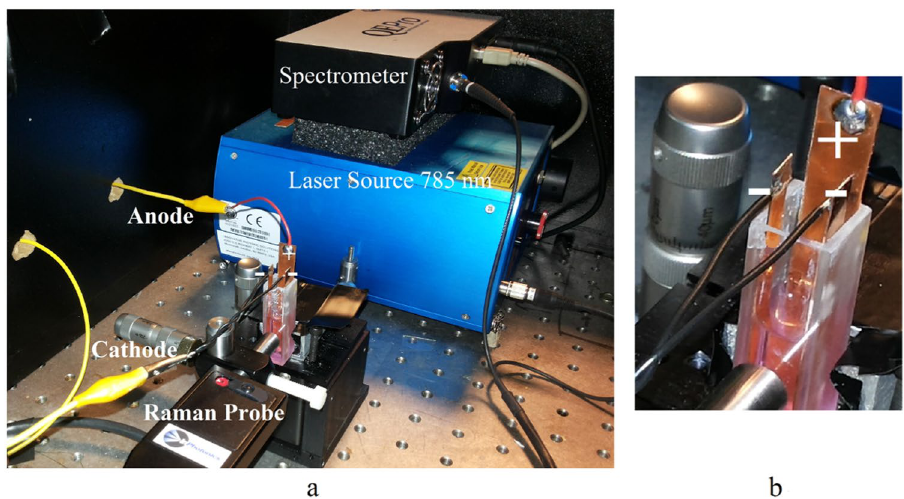
Figure 2. A photograph of the experimental setup for substrate preparation and recording the Raman spectrum. Quartz cuvette and the Raman probe are both set on optical XYZ stages for ease of alignment. Laser light is launched from the Raman probe and the back-scattered light from anode surface propagates back through the Raman probe to the